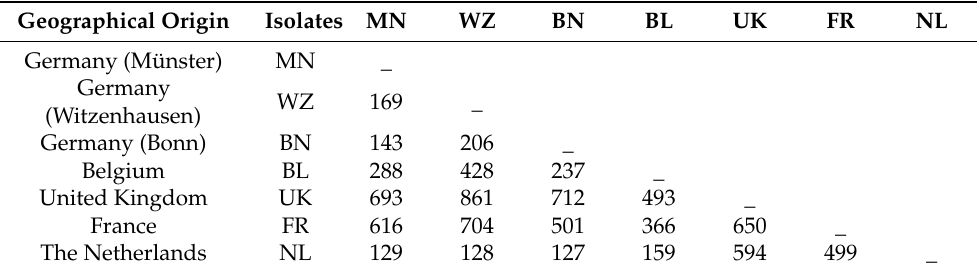
Table 3. Isolate designation, geographical origin, and distance (km) between geographical origins of the seven European